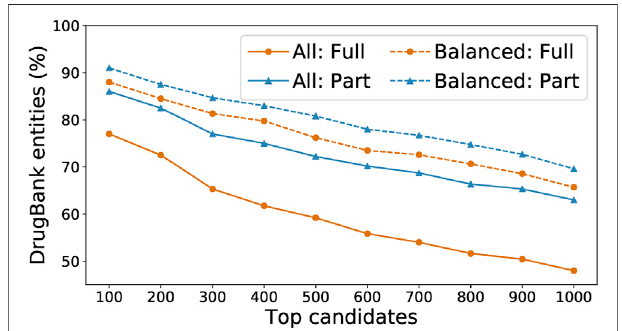
FIGURE 6 | Percentage of detected entities that are also found in DrugBank, when running either on all words found by our model or on just the balanced subset, and with “ found ” de fi ned as either a full or partial match.